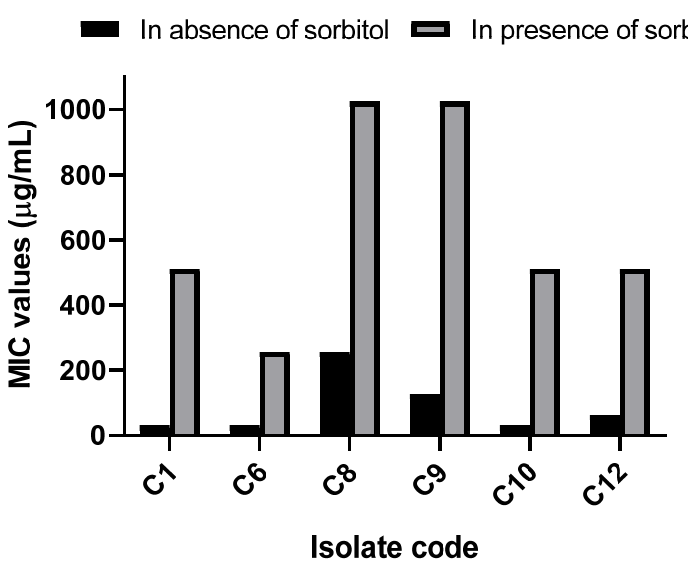
Figure 4. Minimum inhibitory concentration (MIC) values of EVME of six C. glabrata isolates showed a substantial increase ( p < 0.05) in the presence of sorbitol. Table 2. Impact of EVME on efflux pump activity of C. glabrata